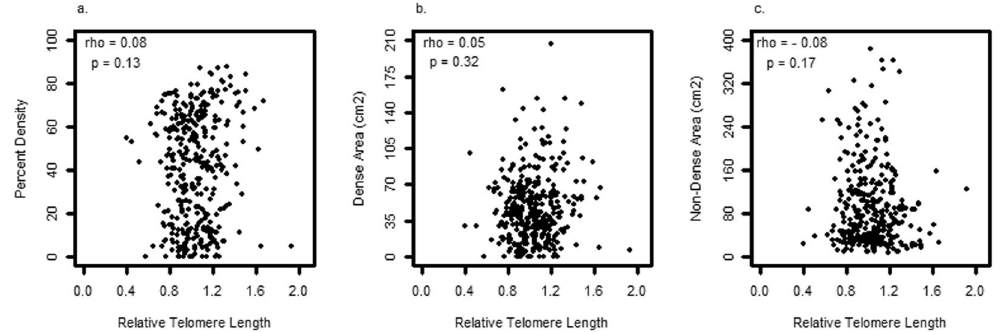
Figure 1. Correlation between relative telomere length and percent mammographic density ( a ), dense area ( b ), and non dense area ( c ). Rho = Spearman correlation